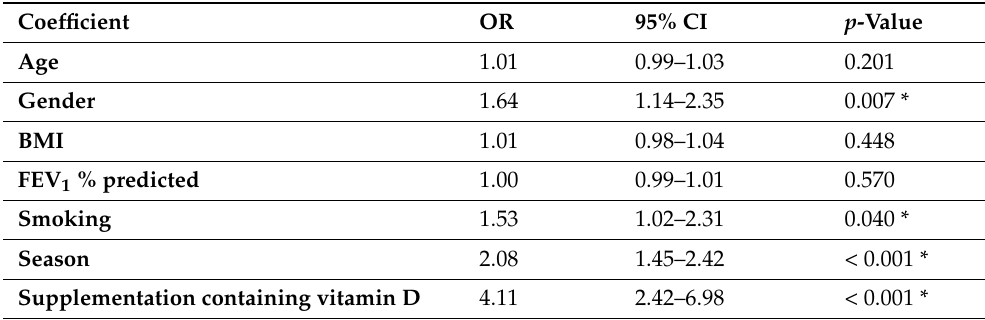
Abbreviations: COPD, Chronic Obstructive Pulmonary Disease. OR, odds ratio. CI, confidence interval. * Signifi- cant p -value < 0.05. BMI, Body mass index. FEV 1 % predicted, Forced expiratory volume in one second in percent of predicted value. n = total number. Coding: 25 Hydroxyvitamin D, >50 nmol/L 0 and <50 nmol/L 1 gender, female 0 and male 1, smoking, former and never-smoker 0 and current 1, documented vitamin D